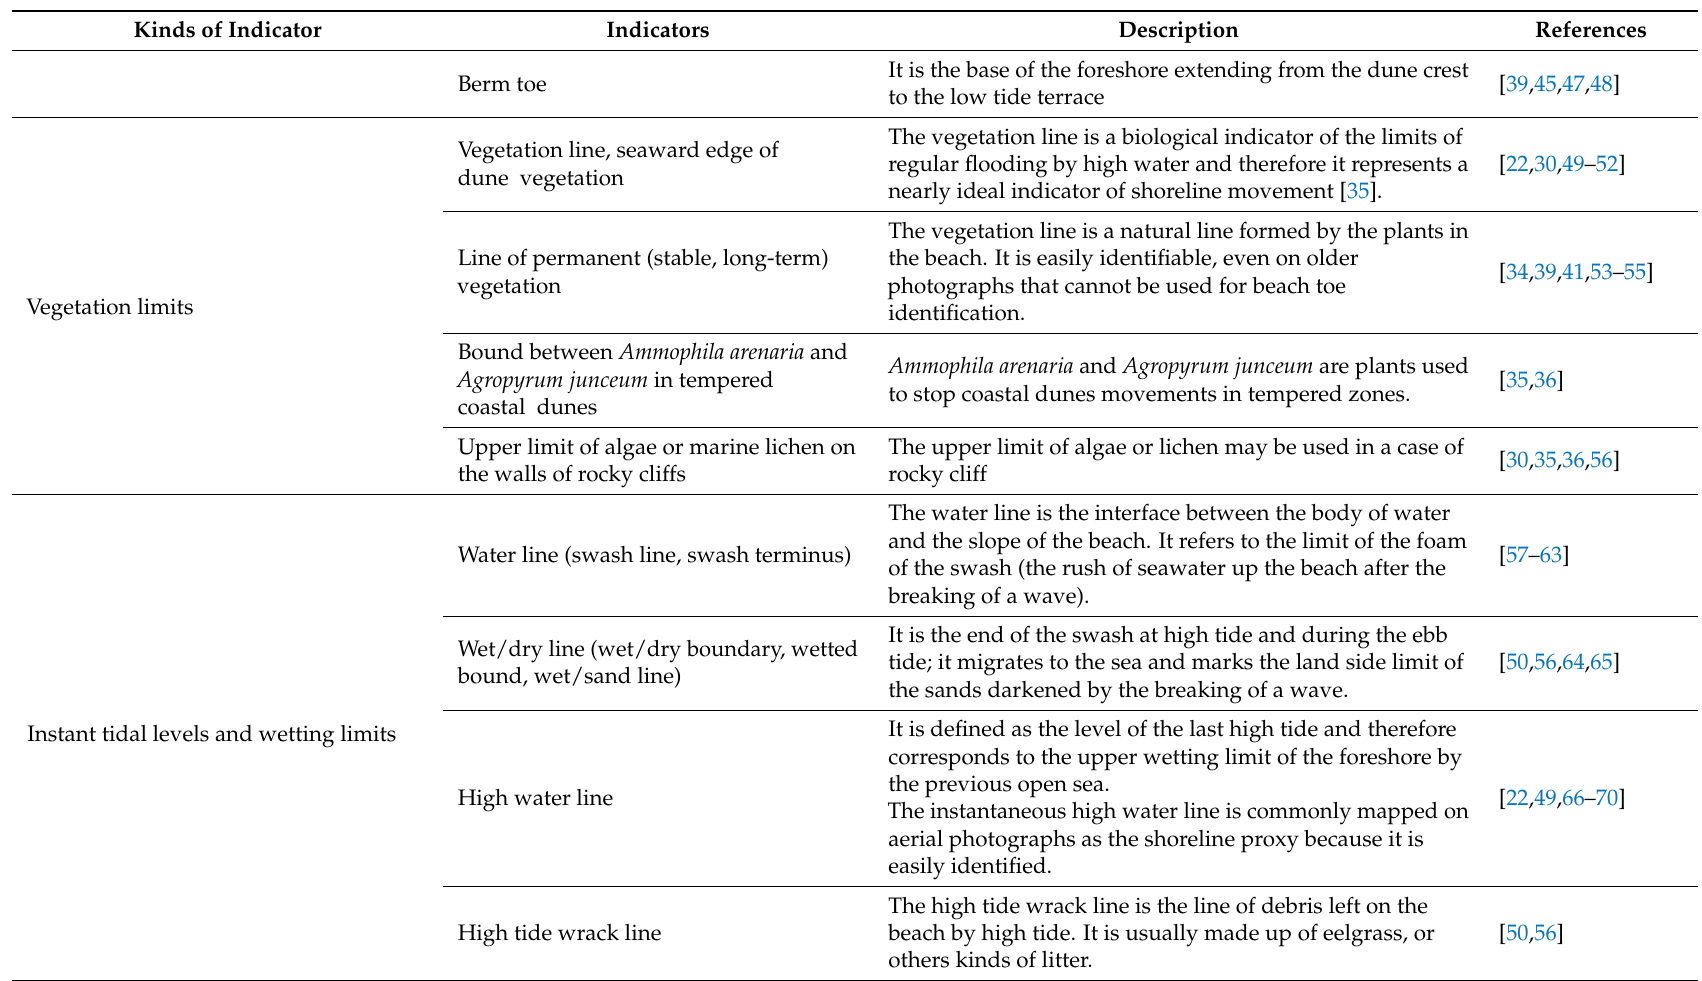
Table 3. Summary of shoreline indicators (adapted from [8,9]